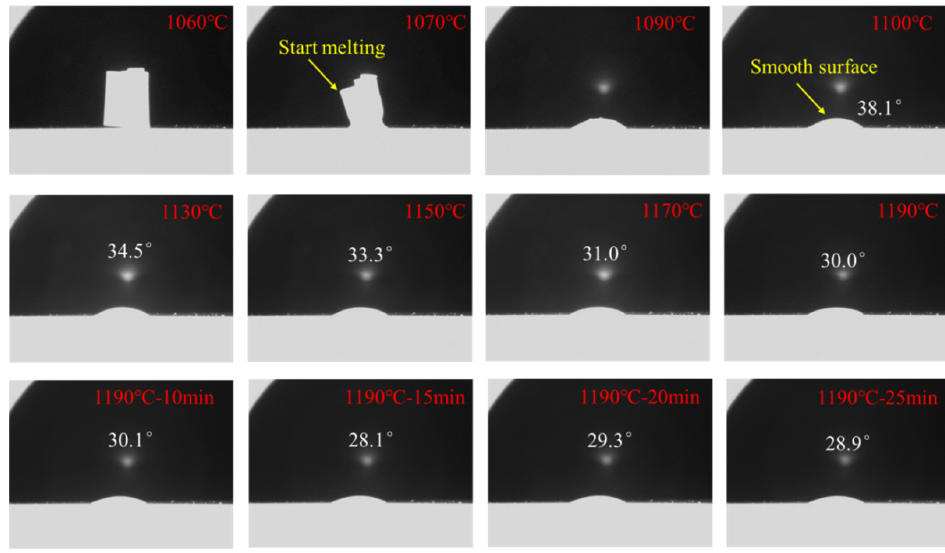
Figure 4. High-temperature contact angle on substrates of acid treatment.